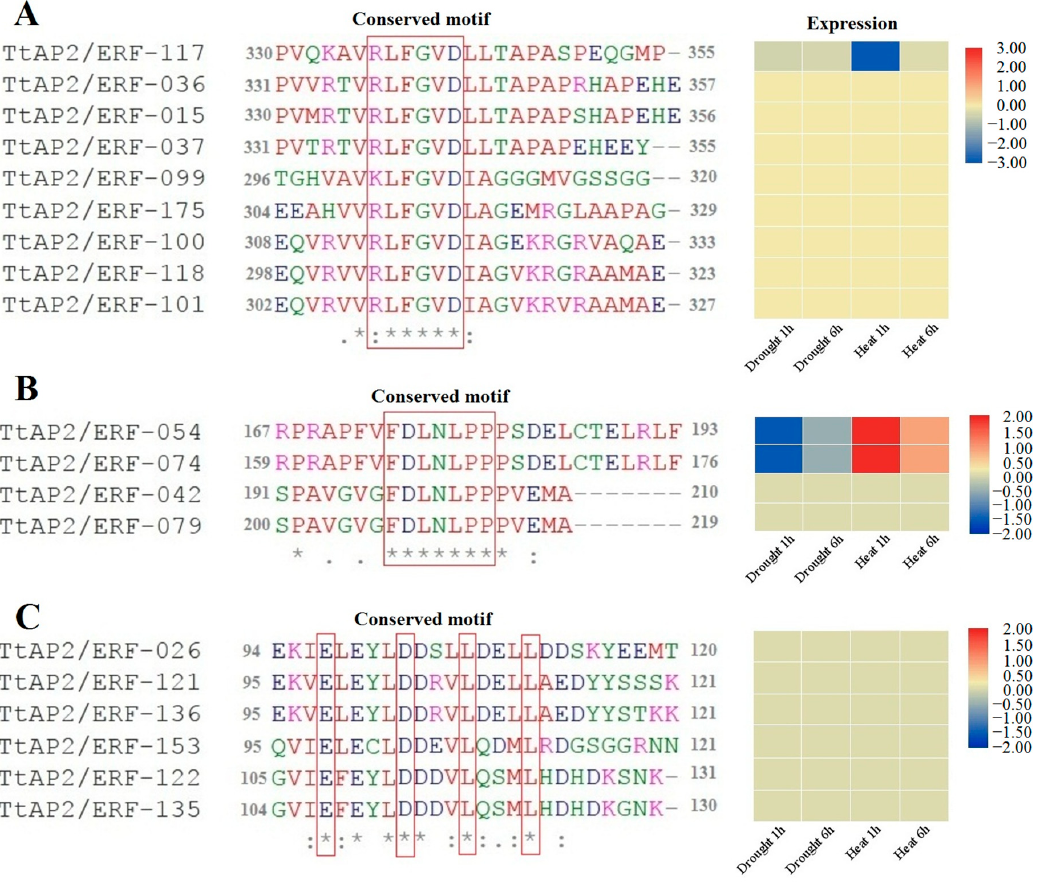
Figure 8. List of TtAP2 / ERF genes contained repressor motifs with their expression. List of genes containing [R / K]LFGV motif ( A ), FDLNLPP motif ( B ), and EDLL motif ( C ).